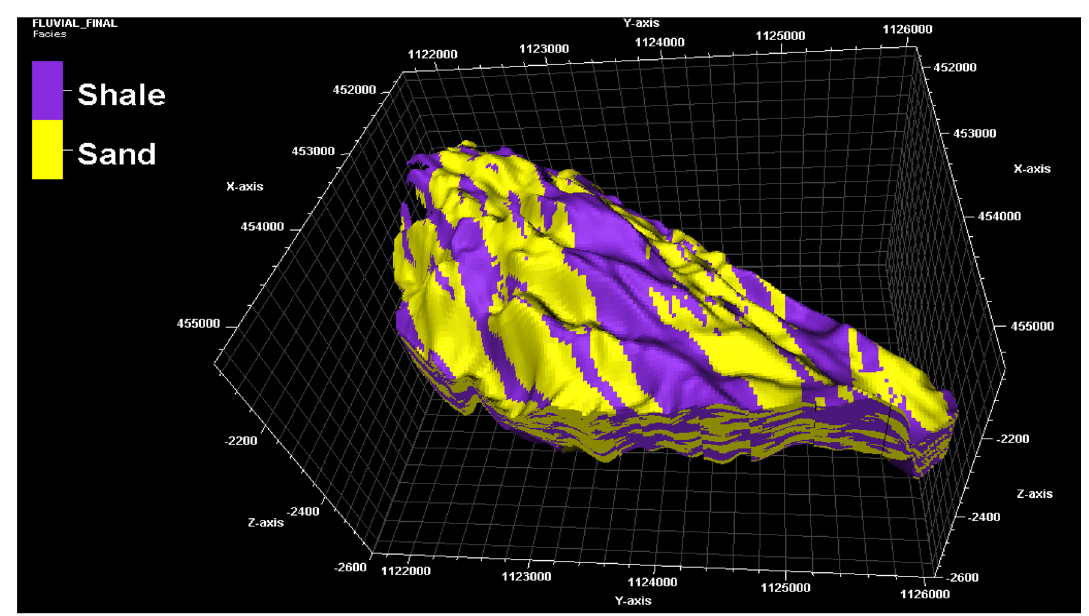
Fig. 8 Facies model in this